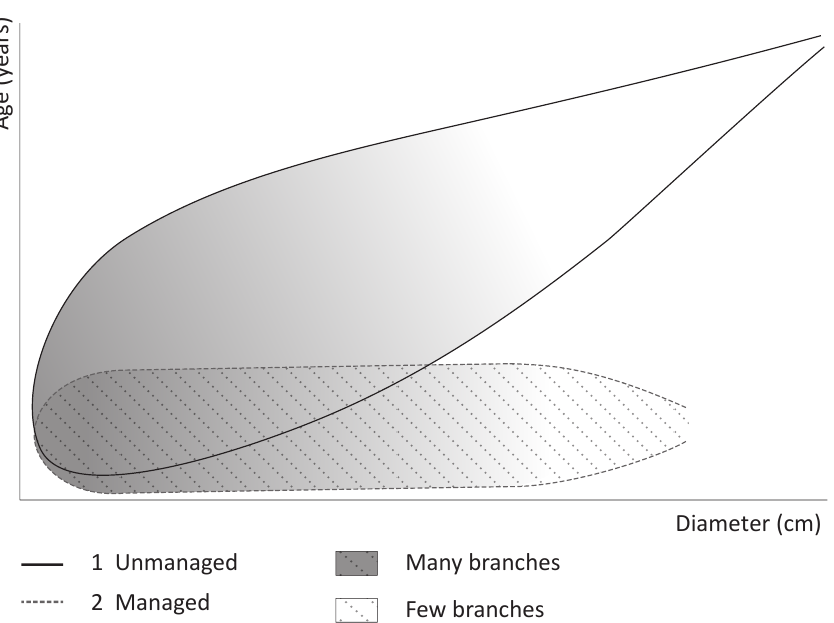
Figure 2. Model for a selection of roundwood and wood derived from roundwood from (1) unman- aged trees, (2) managed trees. This figure is a slightly adapted version of a figure that was published in [9], copyright